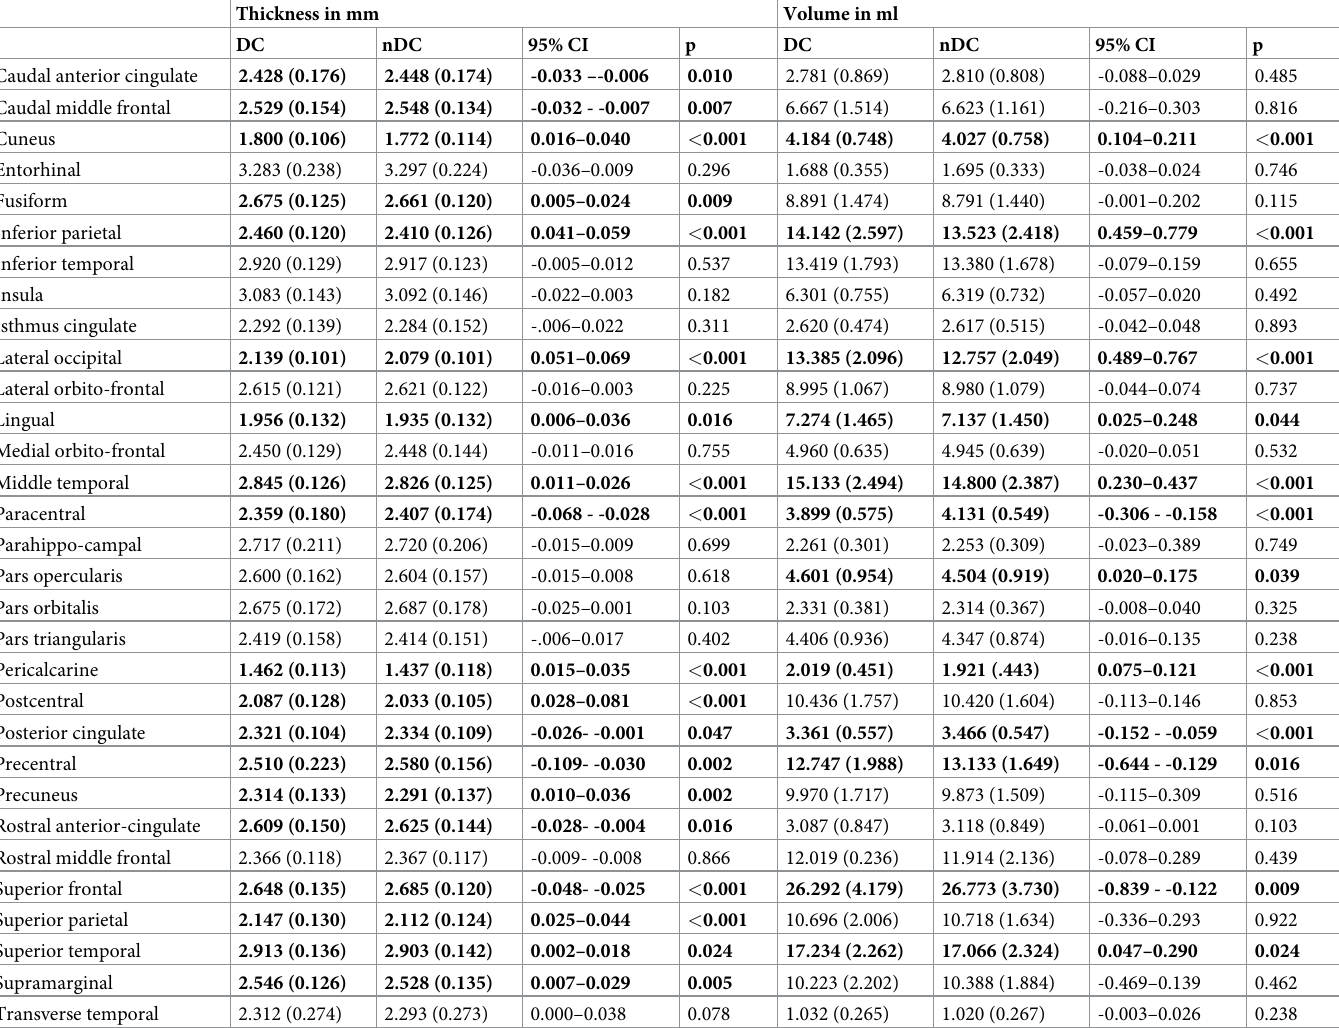
Table 1. Mean values, standard deviations (in parentheses), and 95% confidence intervals for volume and thickness for each cortical